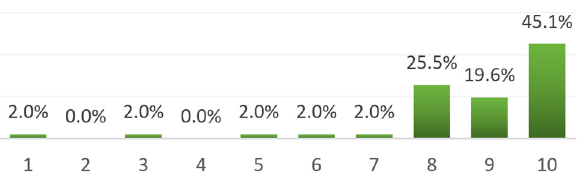
Figure 11. After the presentation, do you better understand how the truss works? (1—not at all, 10—definitely yes).